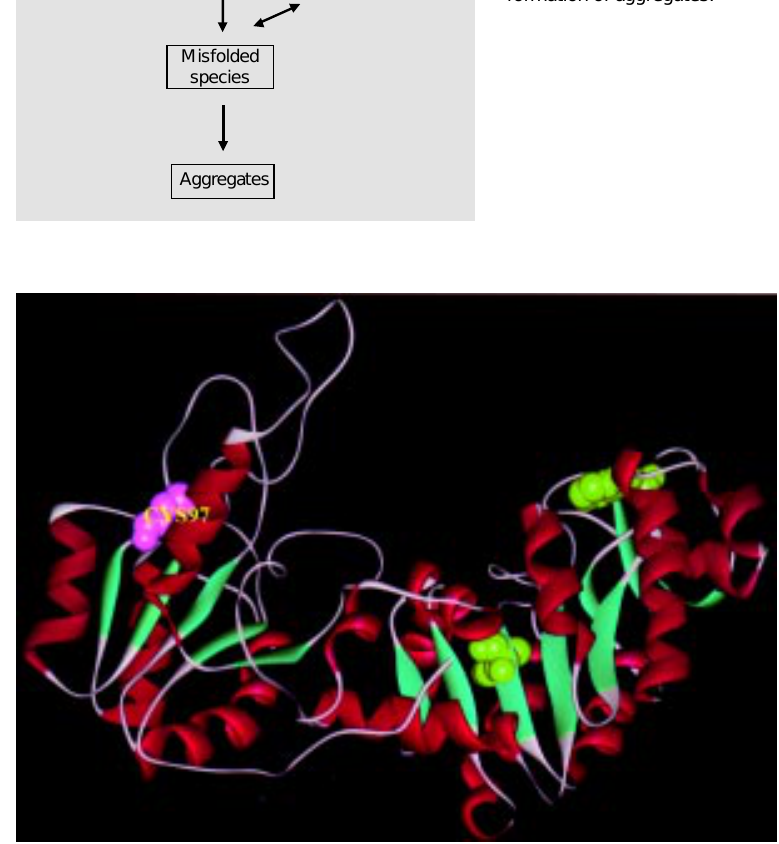
Figure 2 - Structure of yeast phosphoglycerate kinase. The two tryptophans are colored in green and Cys97 in magenta.